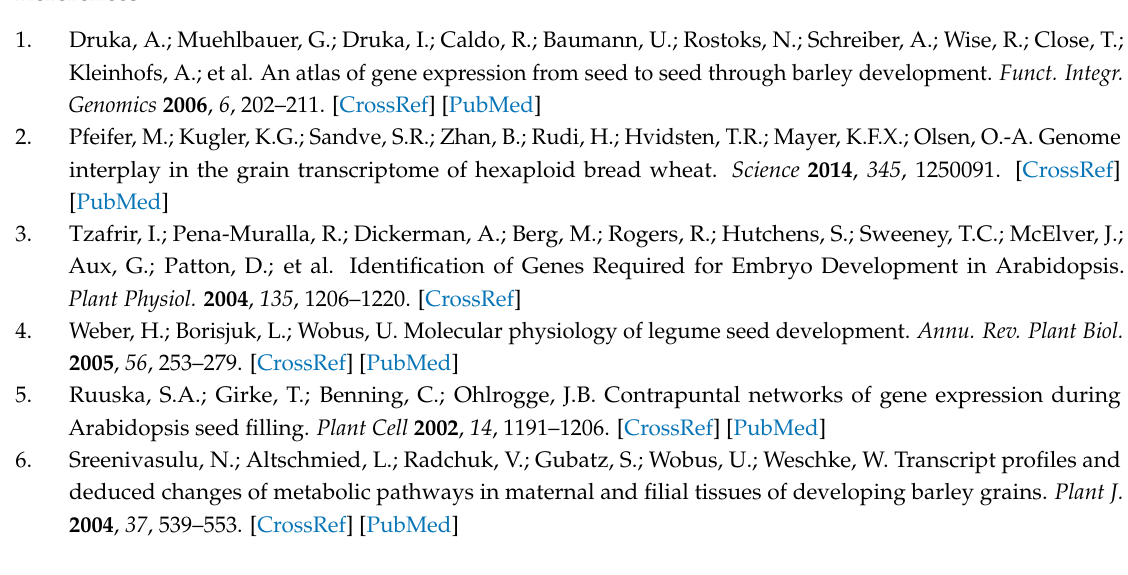
Figure S8: Functional characterization of the differentially expressed genes during barley grain development; Figure S9: Identification of the DEGs involved in hormone signal transduction and sugar metabolism processes; Table S1: RNA-seq read mapping counts against the barley reference genome; Table S2: The expression of genes of all the stages(FPKM>=1); Table S3: The GO enrichment of pre-store stage genes; Table S4: The GO enrichment of store stage genes; Table S5: The set of genes showing stage-specific expression during barley grain development (FPKM < 1 in all other stages); Table S6: Go enrichment of the DEGs clustered in different clusters; Table S7: The detail list of transcription factors (TFs) differentially expressed during barley grain development; Table S8: RNA editing sites in coding regions of morex genome predicted by SPRINT tool; Table S9: The function annotation and expression level of editing DEGs; Table S10: List of putative EMB genes for barley grain